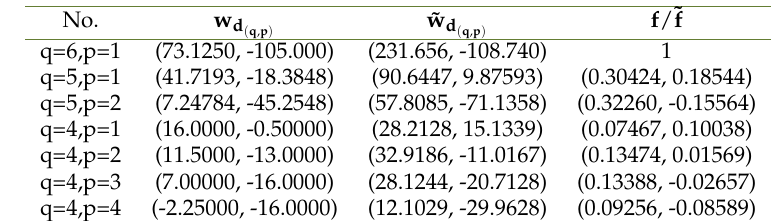
Table 4. TIFV using